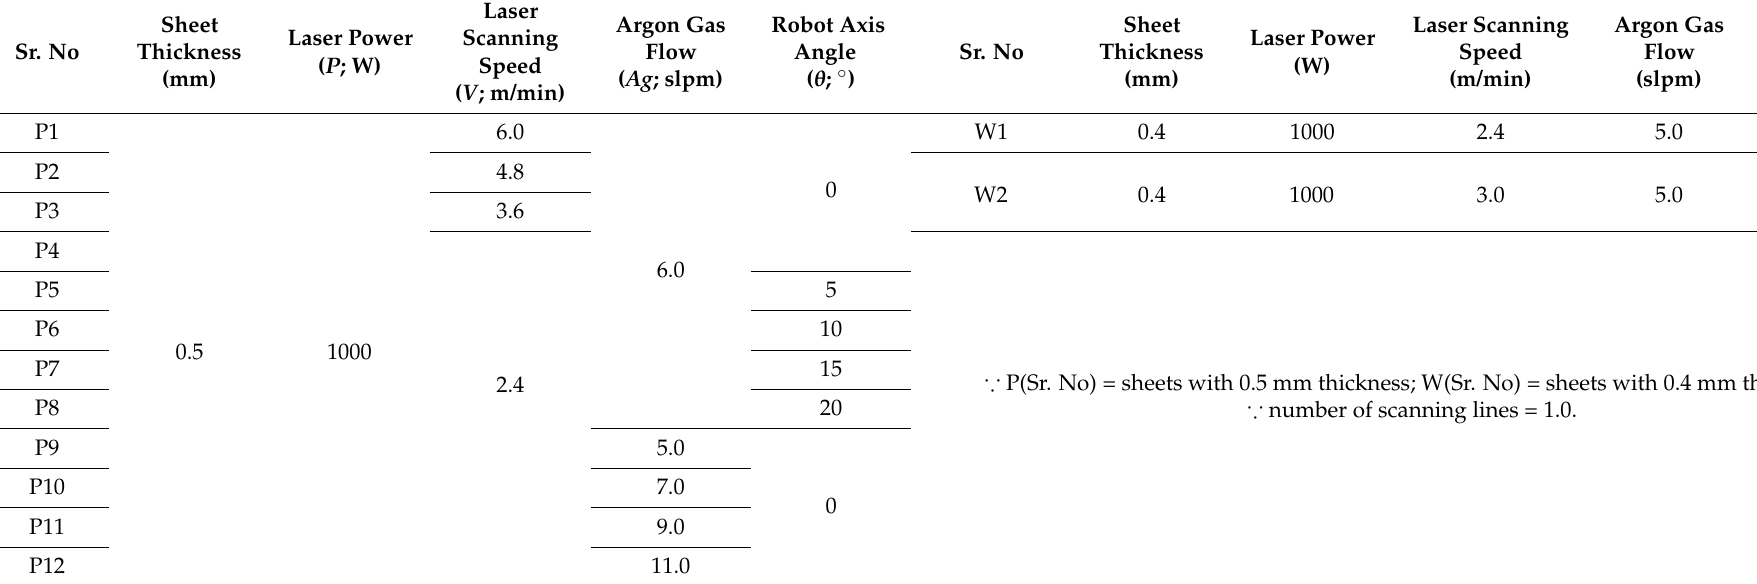
Table 3. Laser welding operating parameters without powder